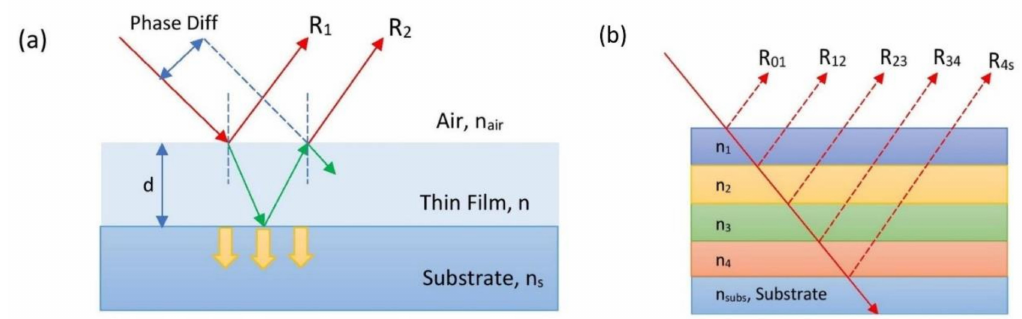
Figure 2. Schematic illustration of di ff usion of light in ( a ) single layer film ( n s > n ) and ( b ) multiple layer